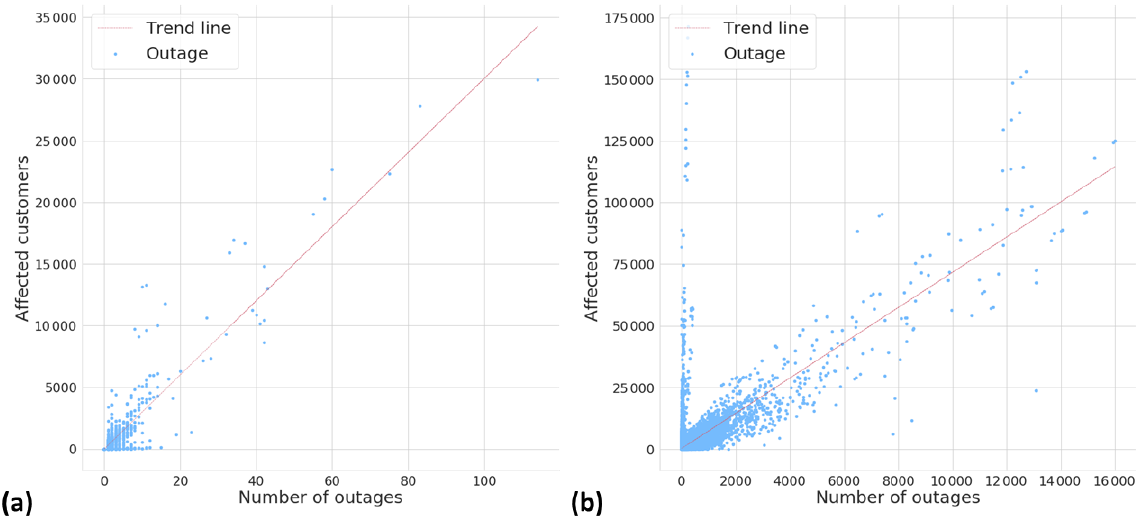
Figure 5. Relationship between number of outages and affected customers in the (a) local dataset and (b) national dataset.